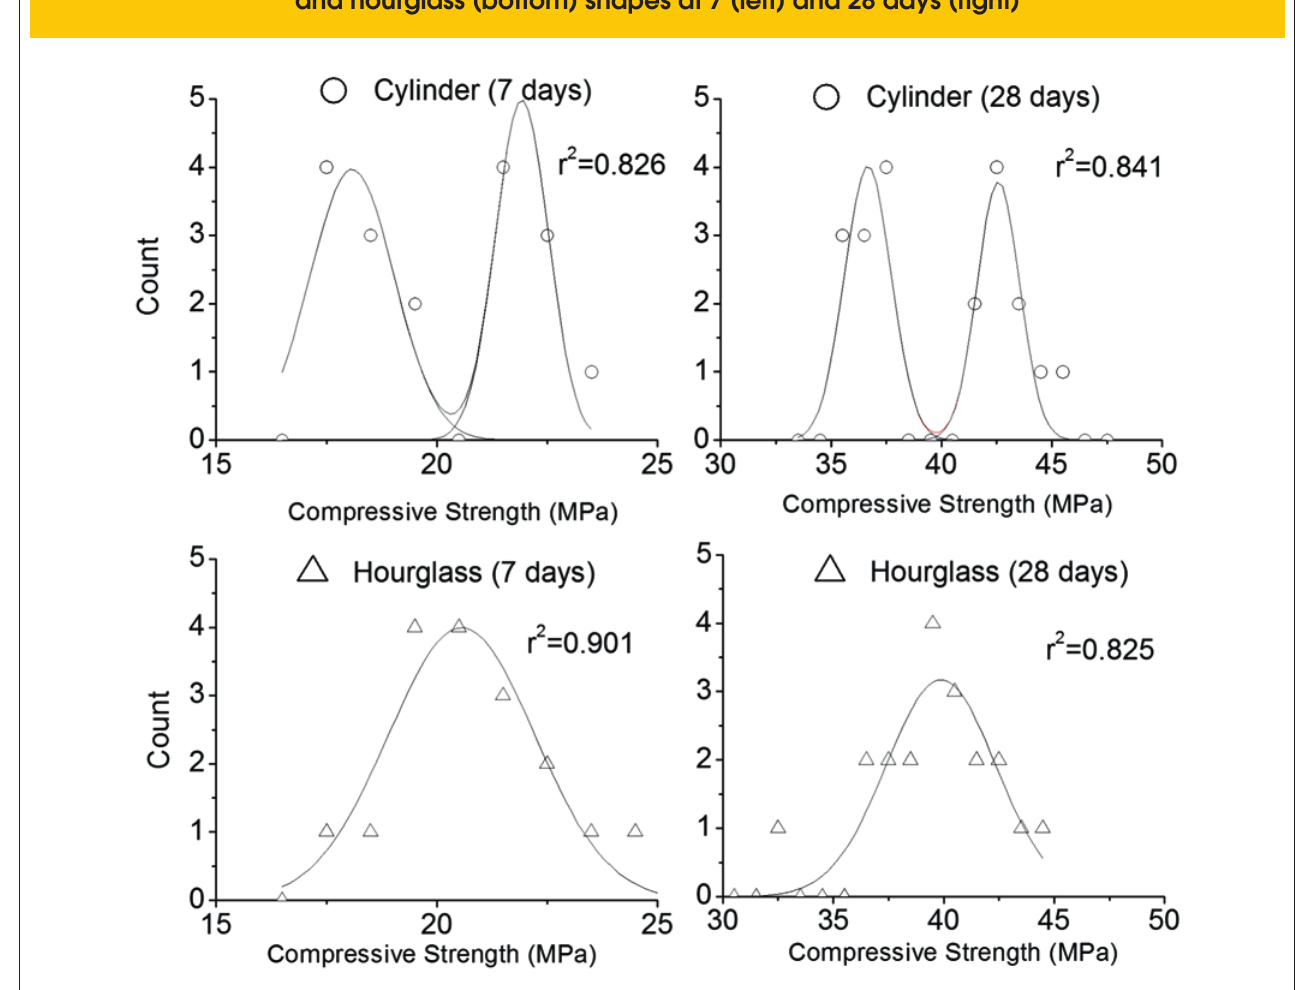
Figure 8 – Compressive strength distribution of cylinder (top) and hourglass (bottom) shapes at 7 (left) and 28 days